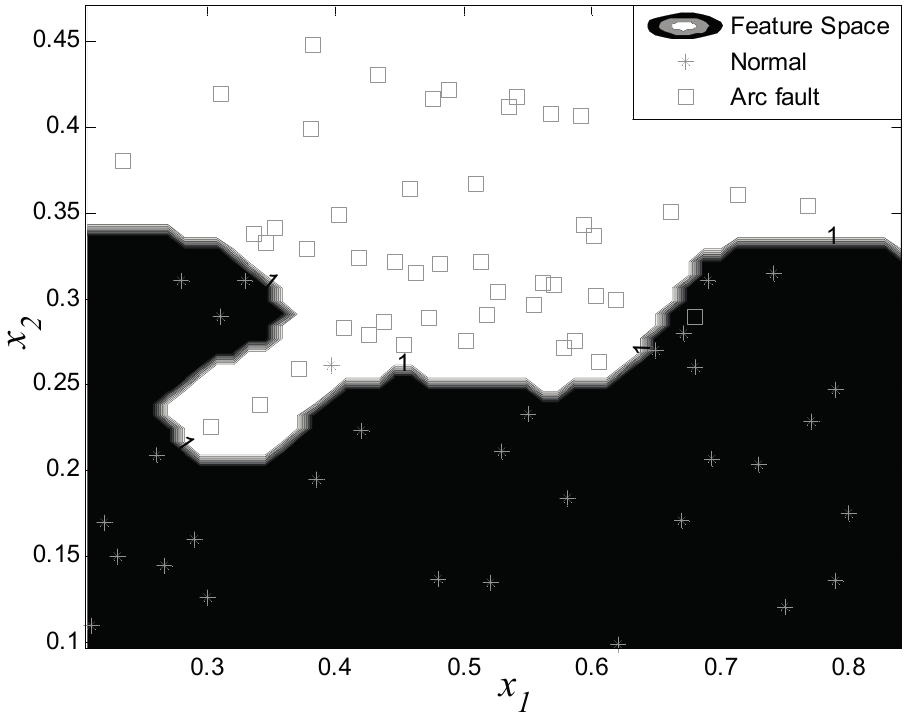
Figure 7. Arc fault identification